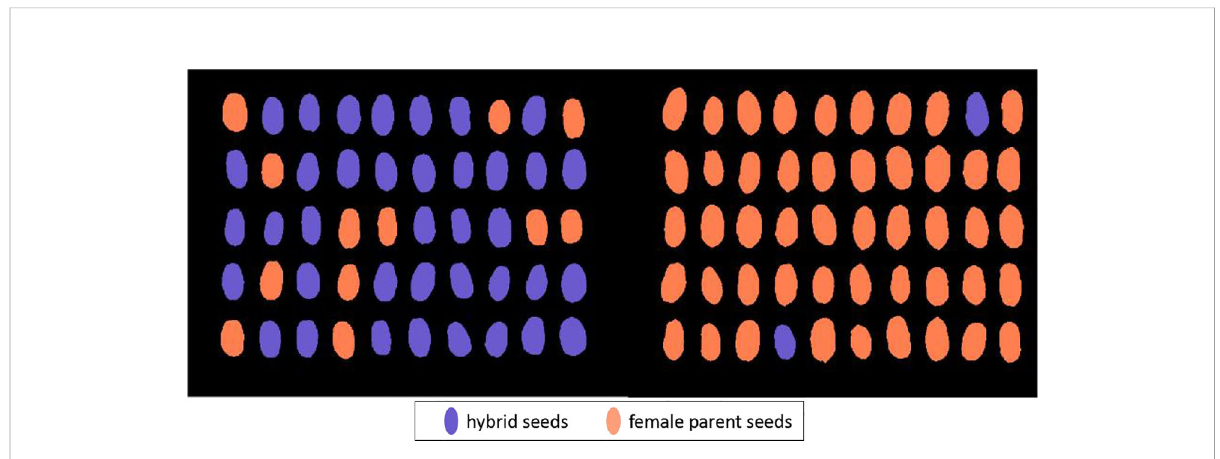
FIGURE 8 Visualization of detection of seeds of Jingmai 9 and its female parent.